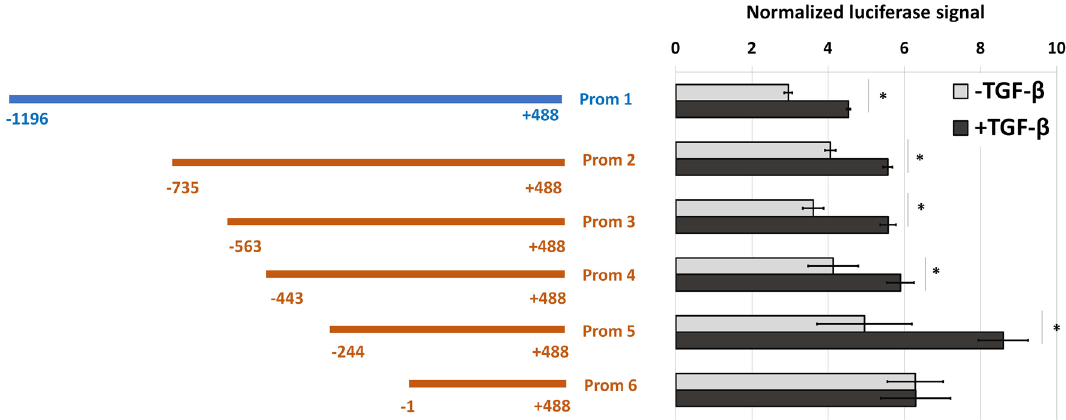
Figure 3. The − 244/− 1 region of the CCL2 promoter is responsible for its TGF-β1-dependent regulation. Functional analysis of deletion variants of the CCL2 promoter. Left, schematic illustration of promoter variants with positions in response to the CCL2 transcription start site. Right, normalized luciferase signals in MDA-MB-231 breast cancer cells in normal conditions and after the incubation with TGF-β1 (10 ng/mL, 24 h). Note that shorter promoter fragments yield smaller plasmid sizes and better transfection efficiencies, resulting in a gradual increase of the overall luciferase signal. The data were obtained in five independent experiments and normalized to the Renilla luciferase activity. *P <